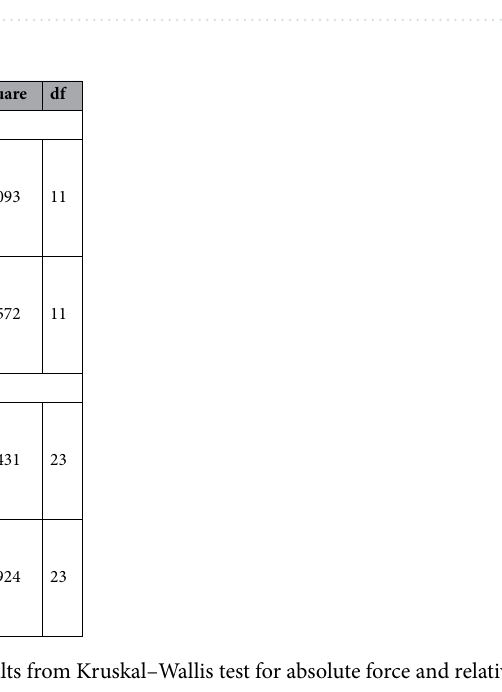
Table 1. For body mass classes: absolute force, mean ± SD (mN), obtained during measurements in both directions (vertical up, vertical down, horizontal posterior, horizontal anterior), and relative force I, mean ± SD (mN/g), with results from Kruskal–Wallis test, and quantity of evaluated radular force measurements (see also Fig. 4). SD, standard deviation.